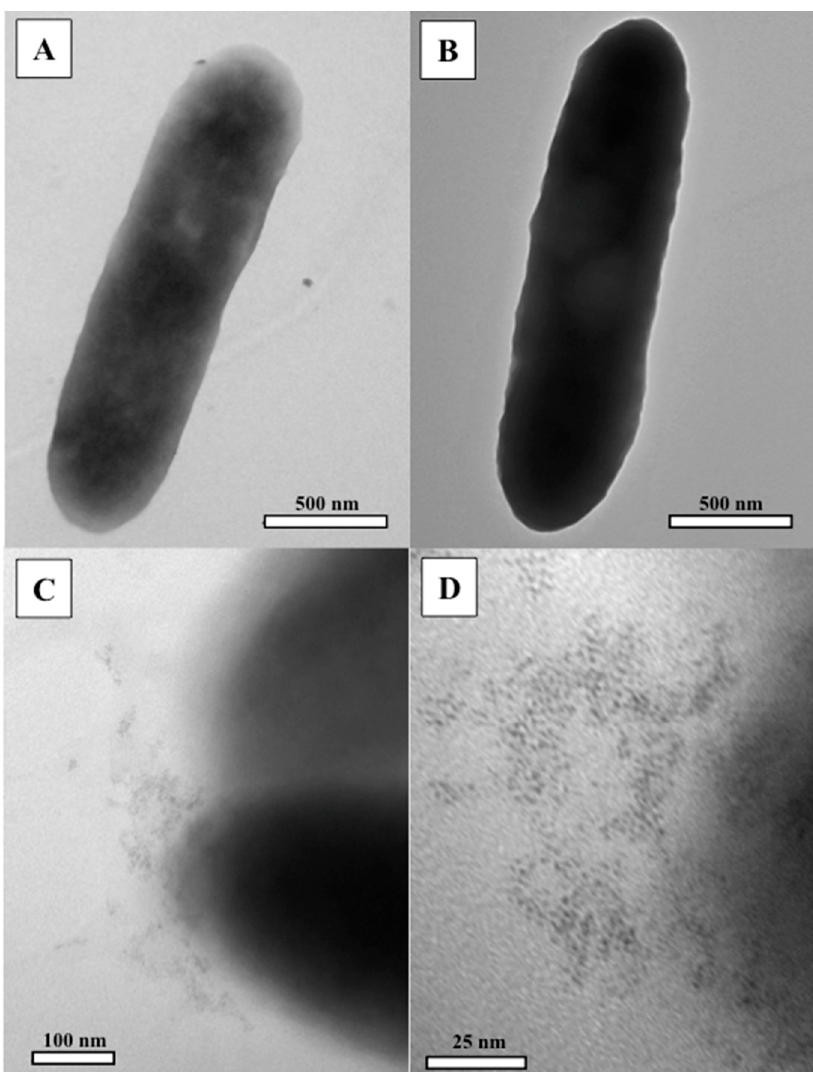
Figure 1. (A ) Whole mount TEM micrograph of an unreacted C. metallidurans cells. Note, the cell envelope is generally electron transparent; ( B ) Unstained, ultra-thin section TEM micrograph of unreacted C. metallidurans . Note the internal detail of cell is lacking because no stain was applied.